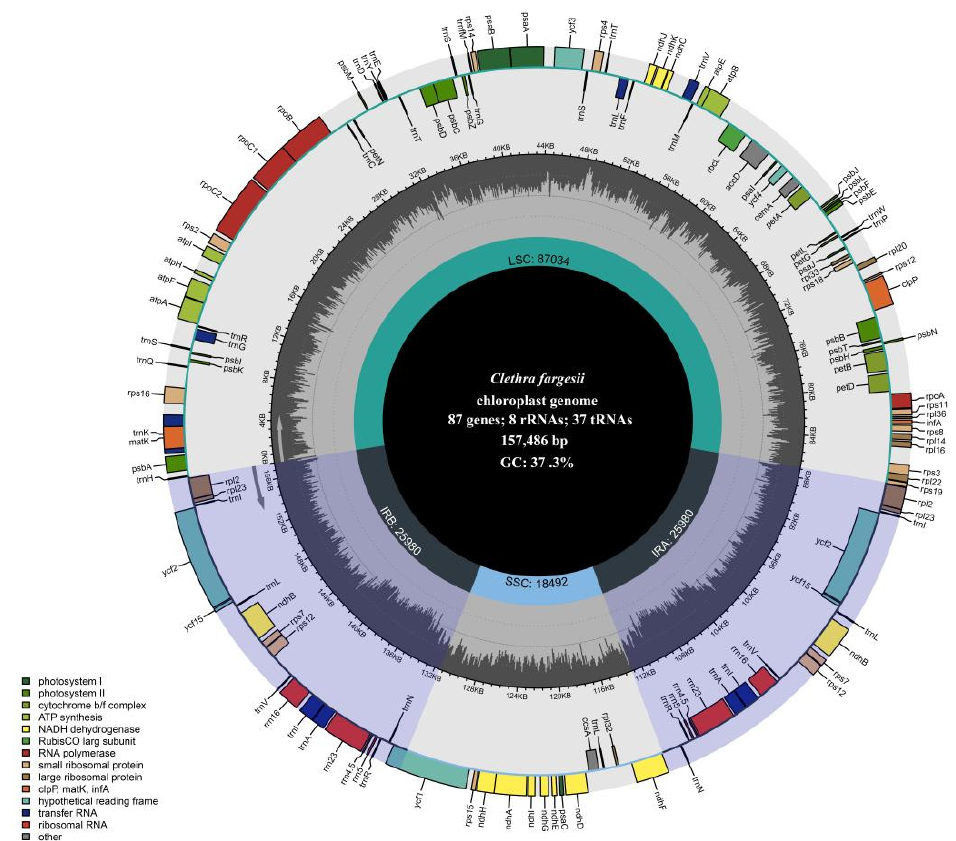
Figure 1. Circular chloroplast genome map of C. fargesii . Genes drawn inside the circle are transcribed counter-clockwise and those outside are clockwise. Genes of different functional groups are colored by different colors. The darker gray in the inner circle corresponds to the DNA GC content, while the lighter gray corresponds to the DNA AT content. Table 1. Features of the complete chloroplast genomes of C. fargesii and seven related species in Ericales order.